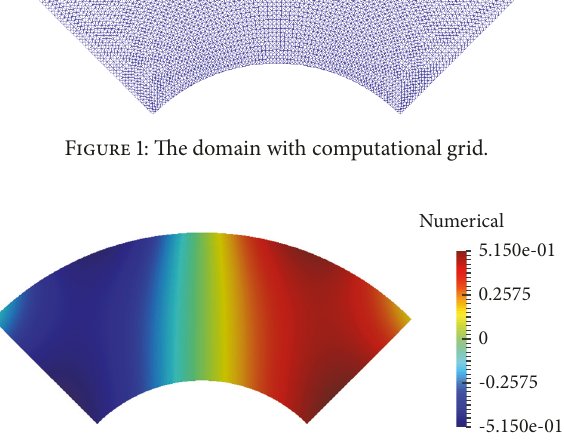
Figure 2: The numerical solutions 𝑢( x ,0)